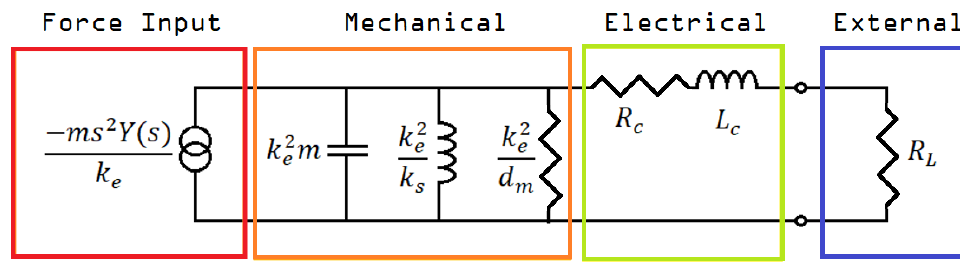
Figure 4. Circuit equivalent of an electromagnetic microgenerator (force input — mechanical parts) connected to an electromagnetic transducer (electrical — external parts).